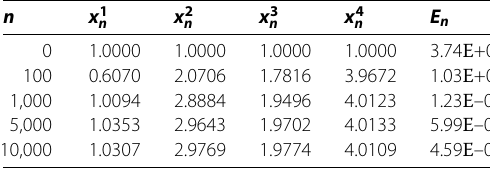
Table 2 Numerical results as regards Example 1 n x 1